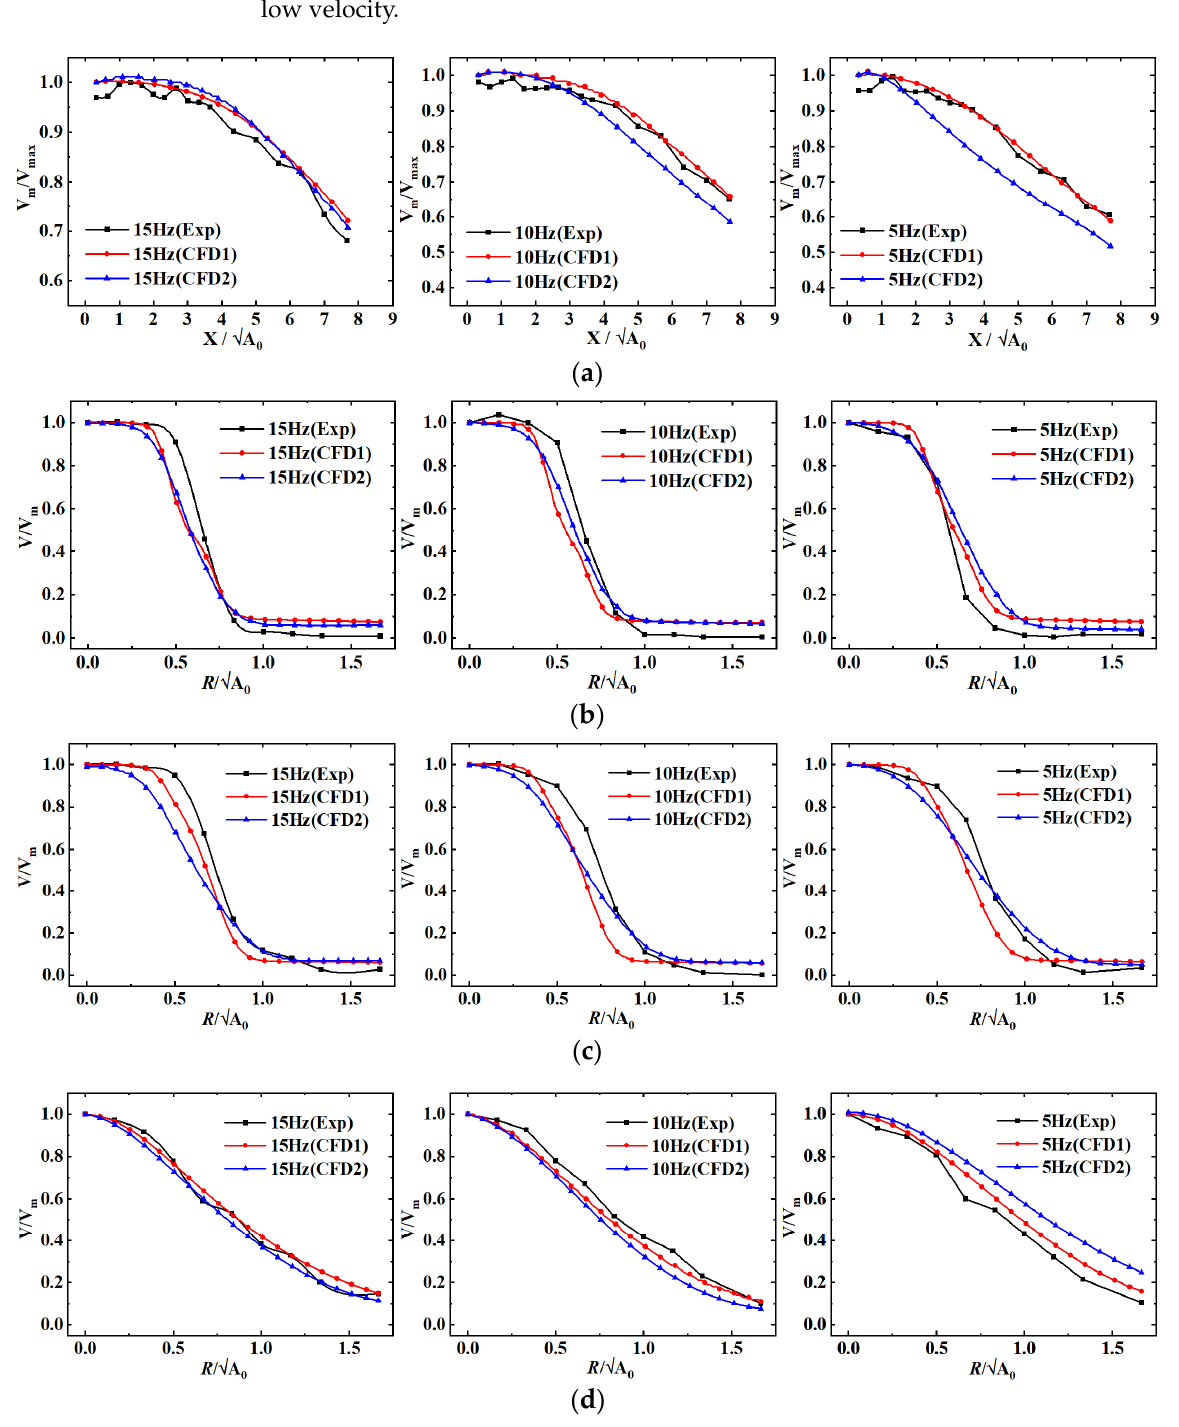
Figure 9. Comparison of measured and numerical profiles for SGD at four positions. ( a ) Pole 1. ( b ) Z 1 . ( c ) Z 2 . ( d ) Z 3 .